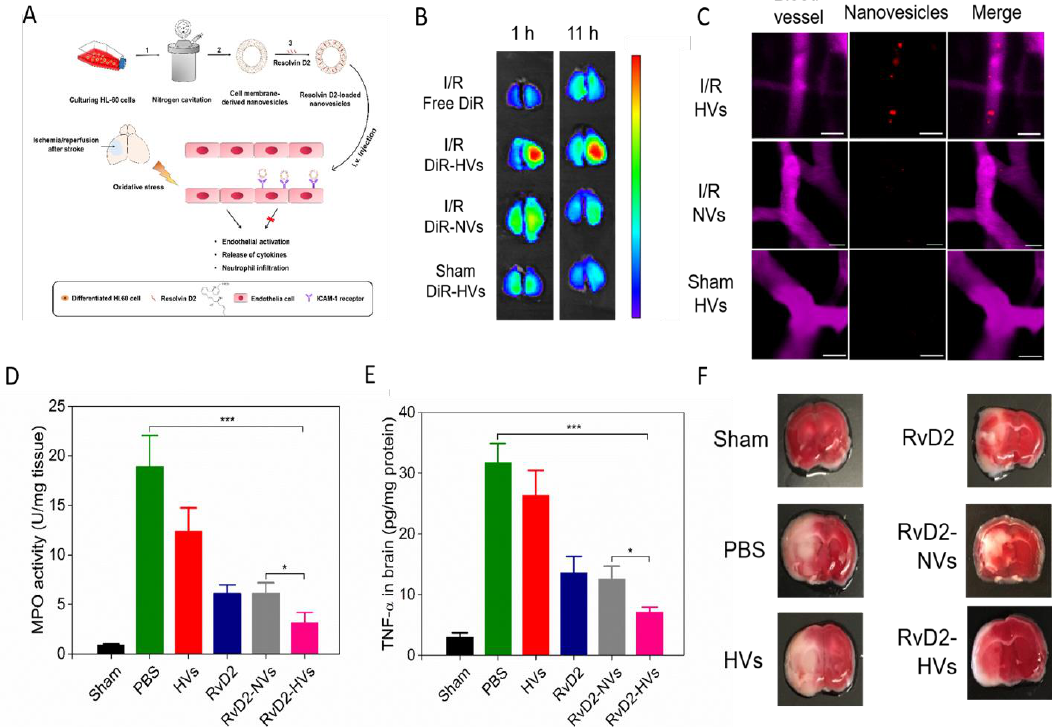
Figure 5. Neutrophil membrane-derived nanovesicles target ischemic endothelium and deliver therapeutics for ischemic stroke treatment. ( A ) A concept of nanovesicles binding to endothelium at ischemic/reperfusion injury sites and alleviating the I/R injury. Resolvin D2-loaded nanovesicles were prepared by: (1) nitrogen cavitation to break the cells; (2) purification; (3) Resolvin D2 loading. ( B ) Nanovesicles (HVs) specifically accumulated in I/R damaged half of brain. ( C ) Intravital microscopy images of HVs (red) specifically bind to I/R endothelium (top panel), instead of normal endothelium (bottom panel). Scale bar = 20 µm. ( D ) Myeloperoxidase (MPO) activity in the injured half of brain after different treatment, which indicates the neutrophil infiltration condition. ( E ) Level of TNF- α in the injured half of brain after different treatment. ( F ) TTC staining of brain sections in different groups. Data represent mean ± standard deviation (SD). * p < 0.05 and *** p < 0.005. Reproduced with permission [68]. Copyright 2019, American Chemical Society.